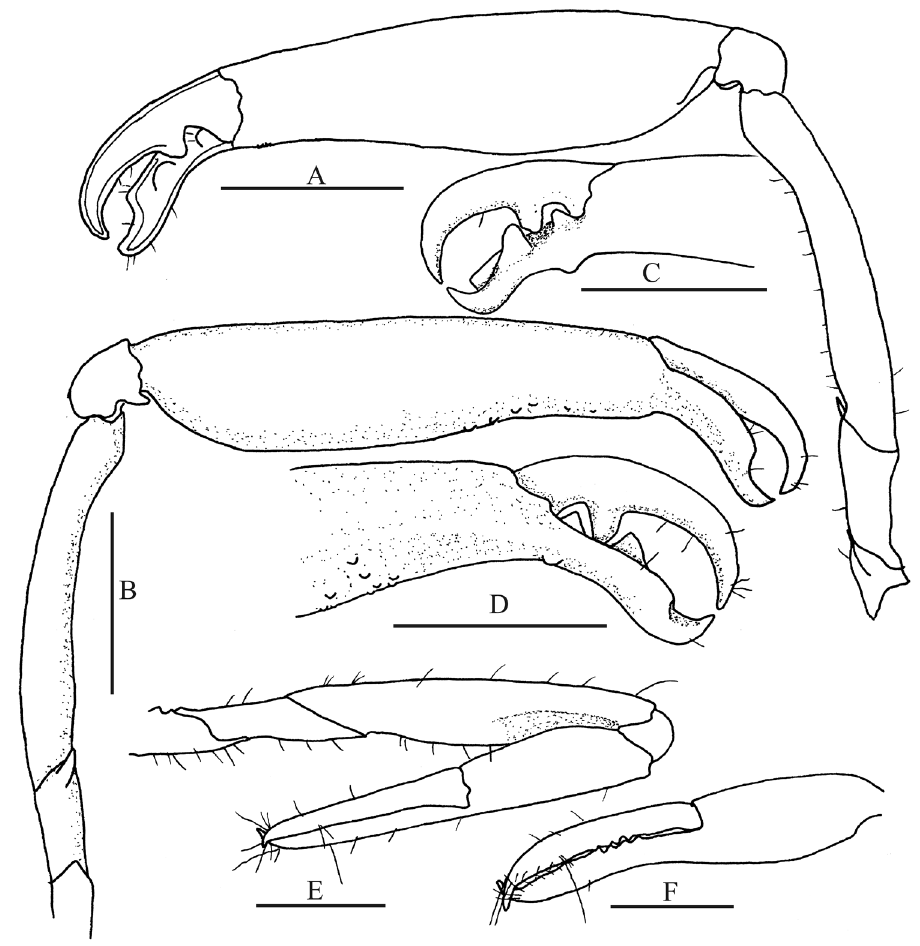
Figure 7. Leptalpheus melendezensis sp. n. Holotype male, CL 4.1 mm (EMU-10582); A major first pereopod, outer view B same, inner view C detail of distal portion of same cheliped, outer view D same, inner view E minor first pereopod, outer view F detail of same cheliped, outer view. Scale bars A, B 1 mm; C–F 0.5